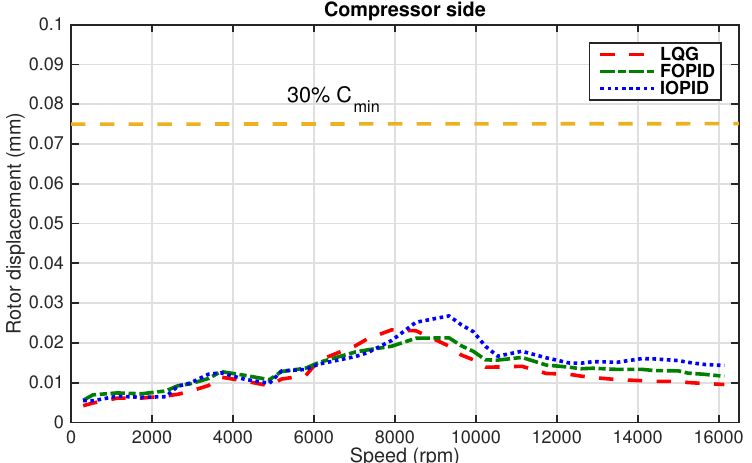
Figure 24. Rotor displacements at the compressor side under the IOPID, FOPID, and LQG